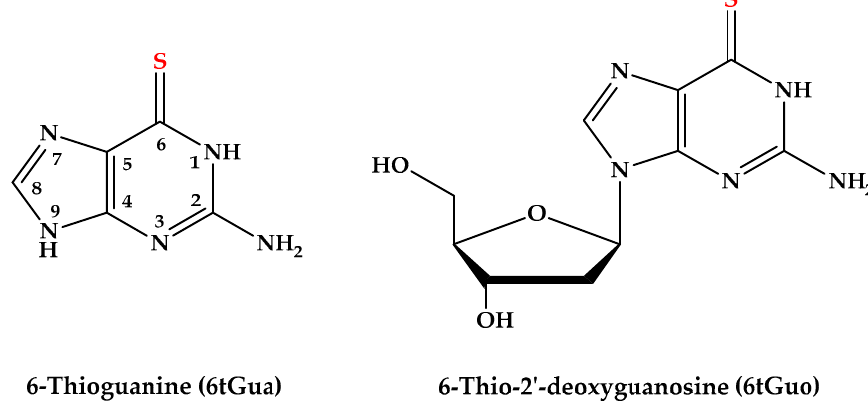
Figure 1. Molecular structures and common ring numbering of the nucleobase chromophore.